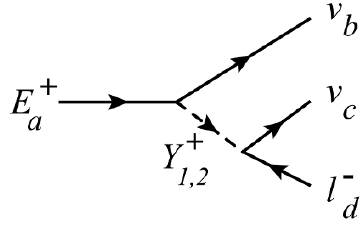
Figure 2 . This decay is allowed even for the lightest lepton E